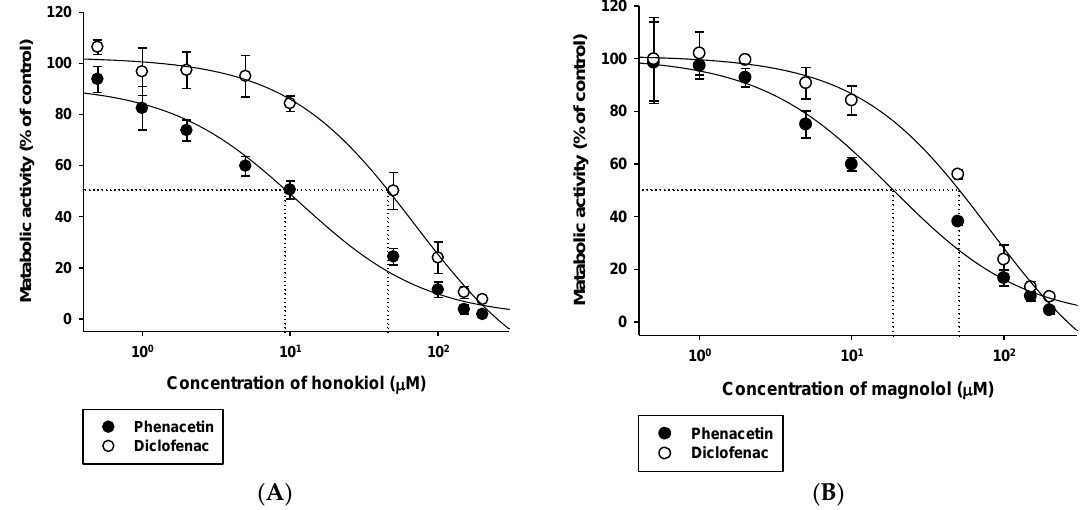
Figure 2. Effects of honokiol ( A ) and magnolol ( B ) on metabolic reactions of phenacetin (●) and diclofenac ( ○ ) in rat liver microsomes. The bullet symbols and their error bars represent the means and standard deviations, respectively ( n = 4).